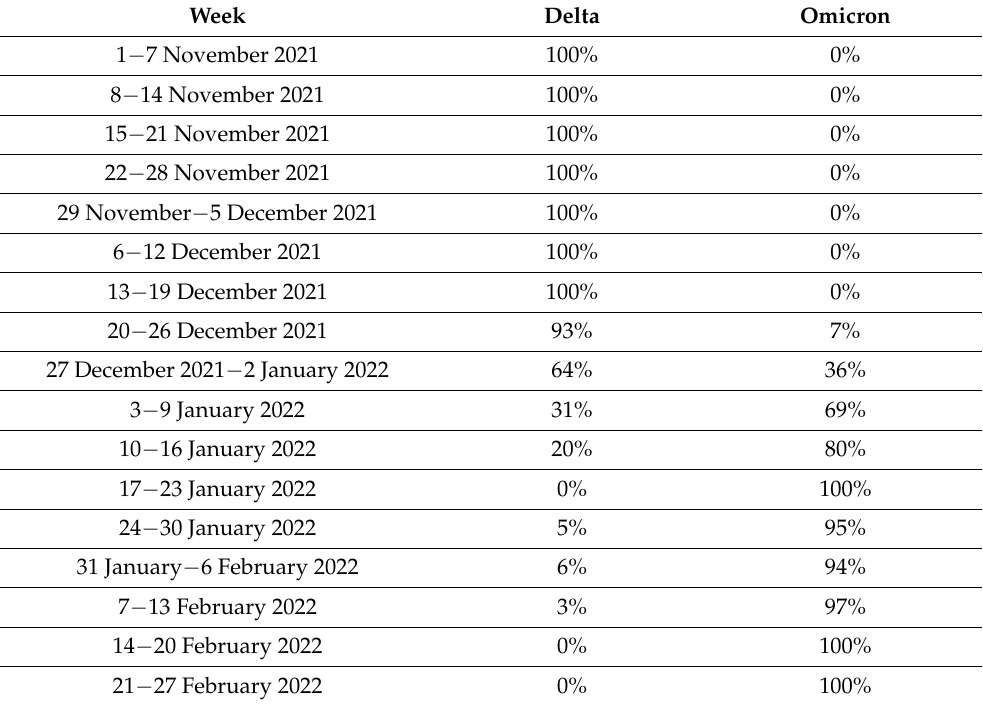
Table 2. Weekly percentage distributions of SARS-CoV-2 variants identified by viral genome sequenc- ing in new positive samples of the Romagna